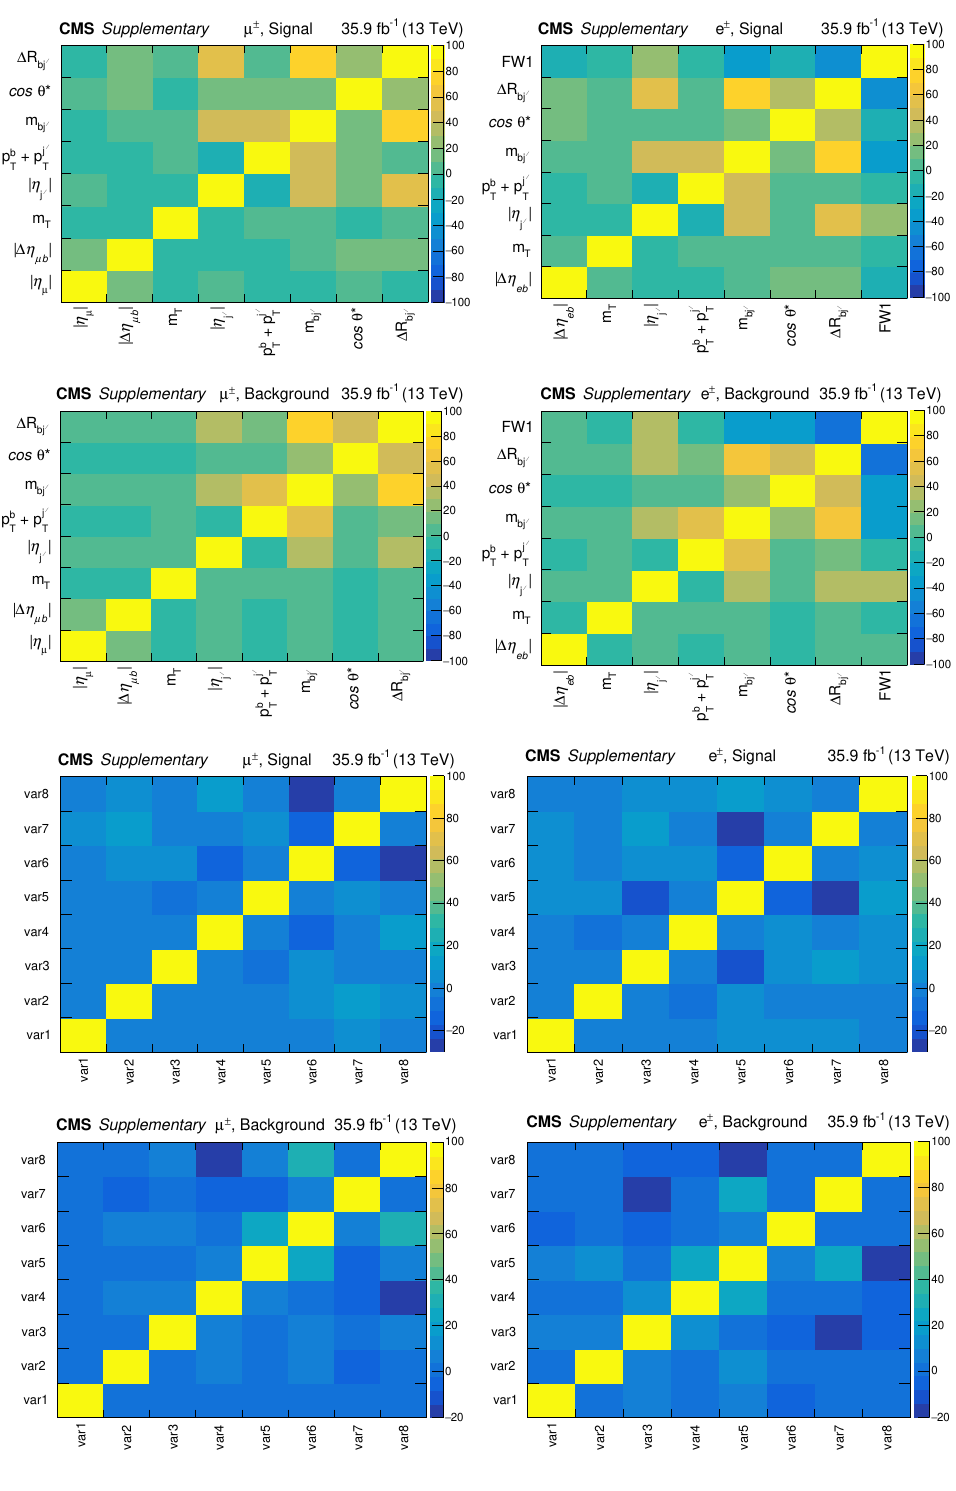
Figure 13 . Correlations in % among the BDT input variables used for the muon (left) and electron (right) final states in the signal and background events of the 2J1T category before (upper-two rows) and after (lower-two rows)